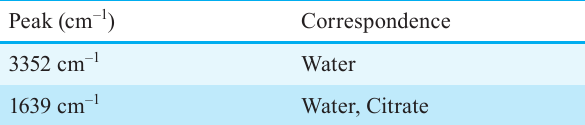
Fig. 5 FT-IR data of the 15 nm AuNPs sample. Table 3 FT-IR data of the 15 nm AuNPs sample.